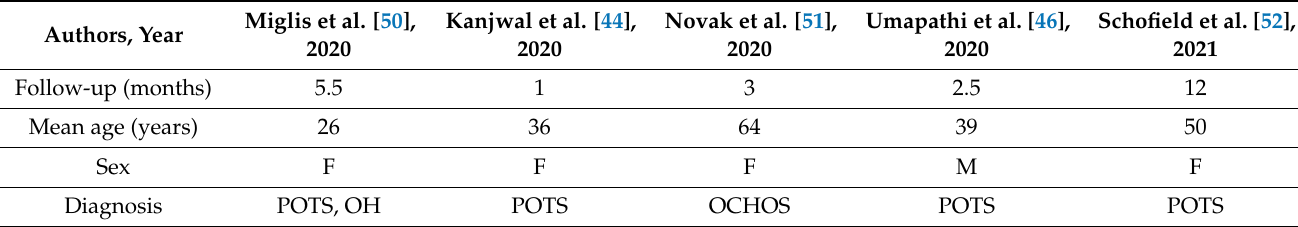
Table 1. Case reports of patients diagnosed with CVAD following